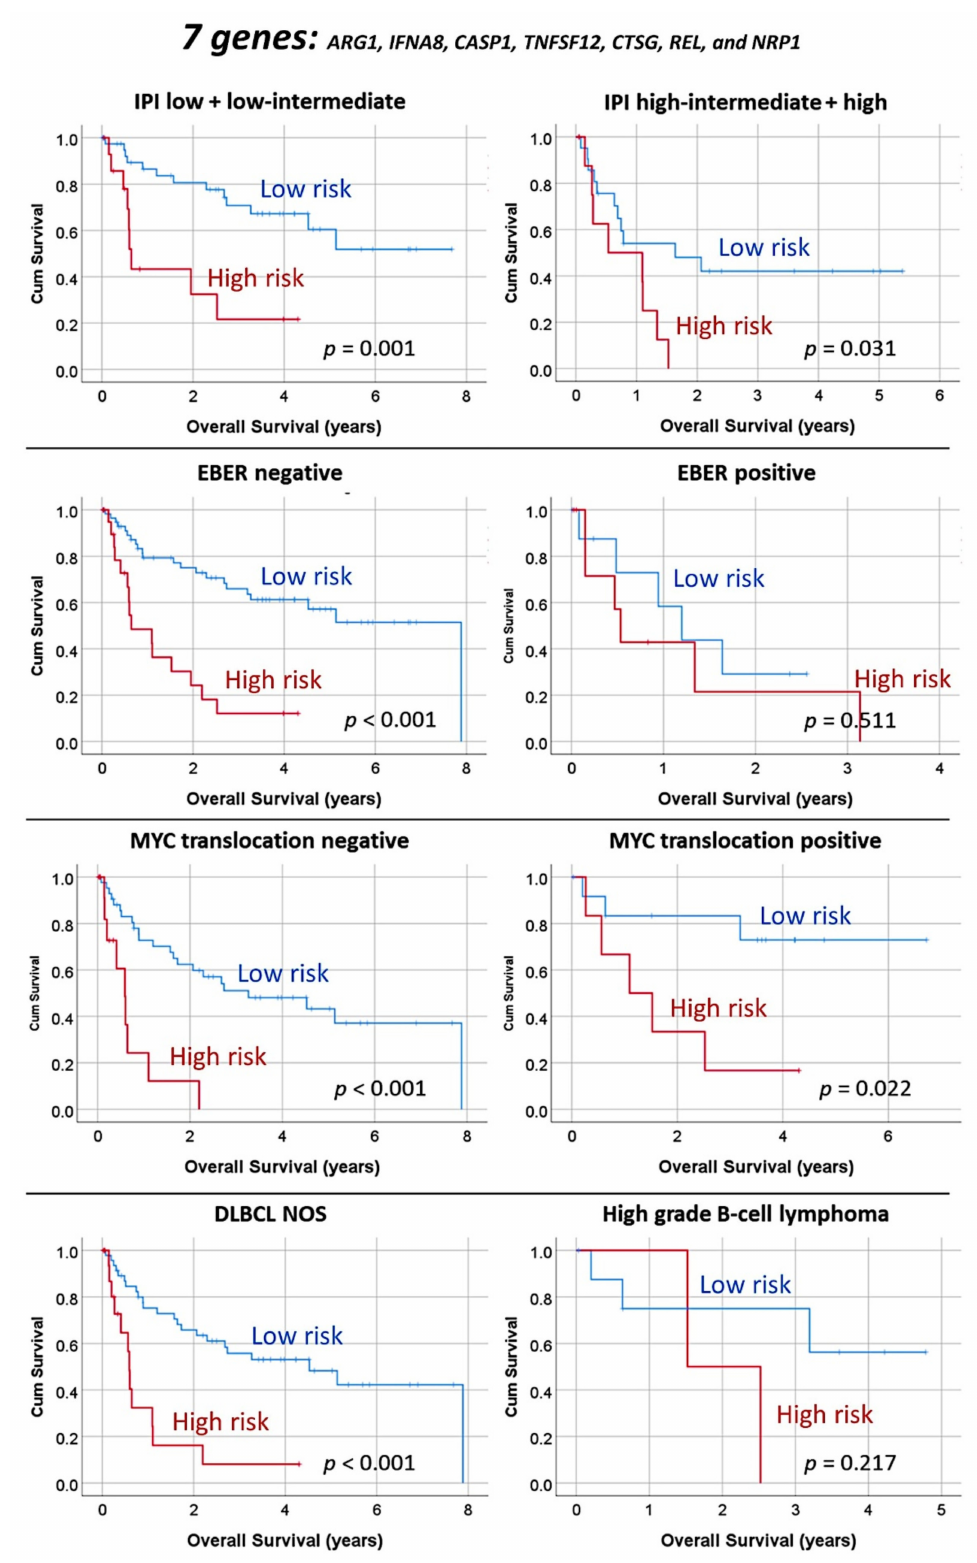
Figure 9. Overall survival according to the top genes of the MLP analysis in DLBCL subtypes/entities. As a result of the MLP and the multivariate Cox regression analysis a final set of 7 genes were highlighted. Using a risk-score formula, the cases were divided into high and low-risk groups that had different overall survival when stratifying for IPI, Epstein Barr virus infection (EBER), MYC rearrangement and High-grade B-cell lymphoma with MYC and BCL2 and/or BCL6